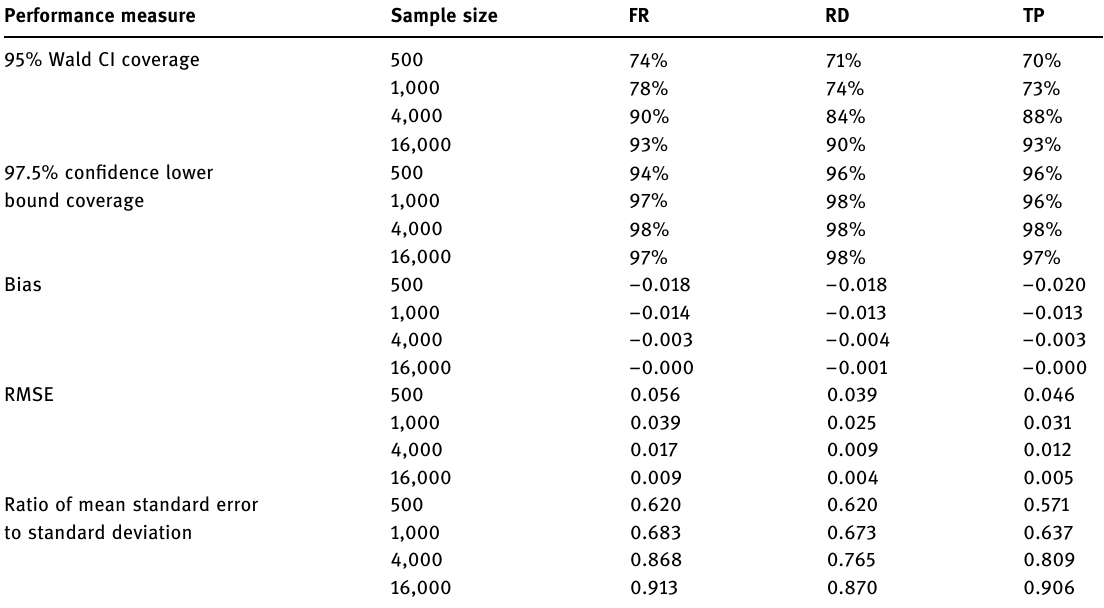
Table 1: Performance of estimators of ATEs in the simulation with nuisance functions estimated via machine learning Performance measure Sample